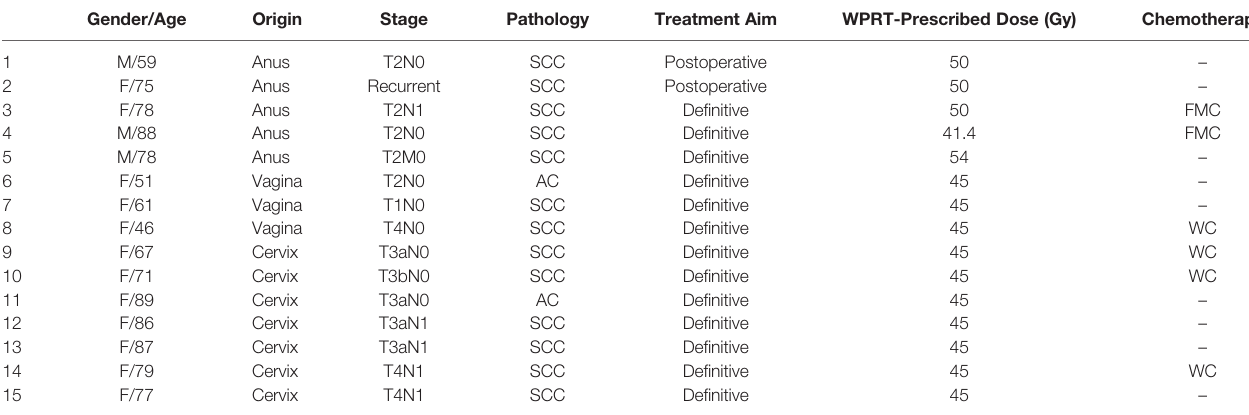
TABLE 1 | Characteristics of patients, tumors, and treatment regimen selected for whole pelvic radiation therapy.